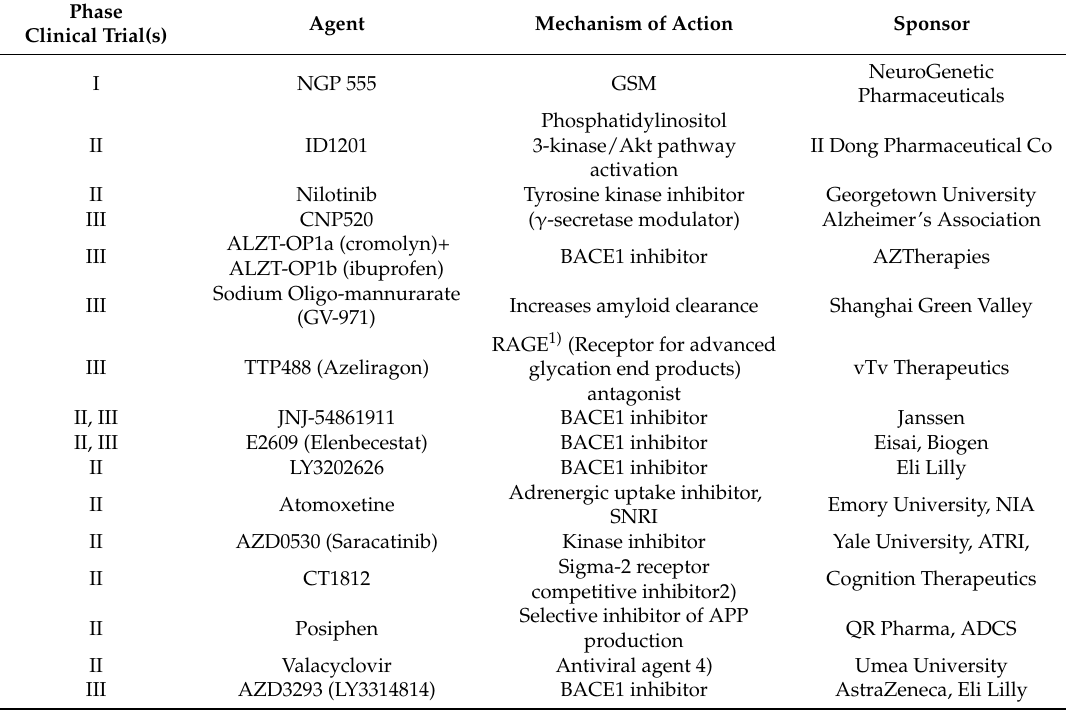
Table 3. Small molecules (amyloid related) in AD pipeline